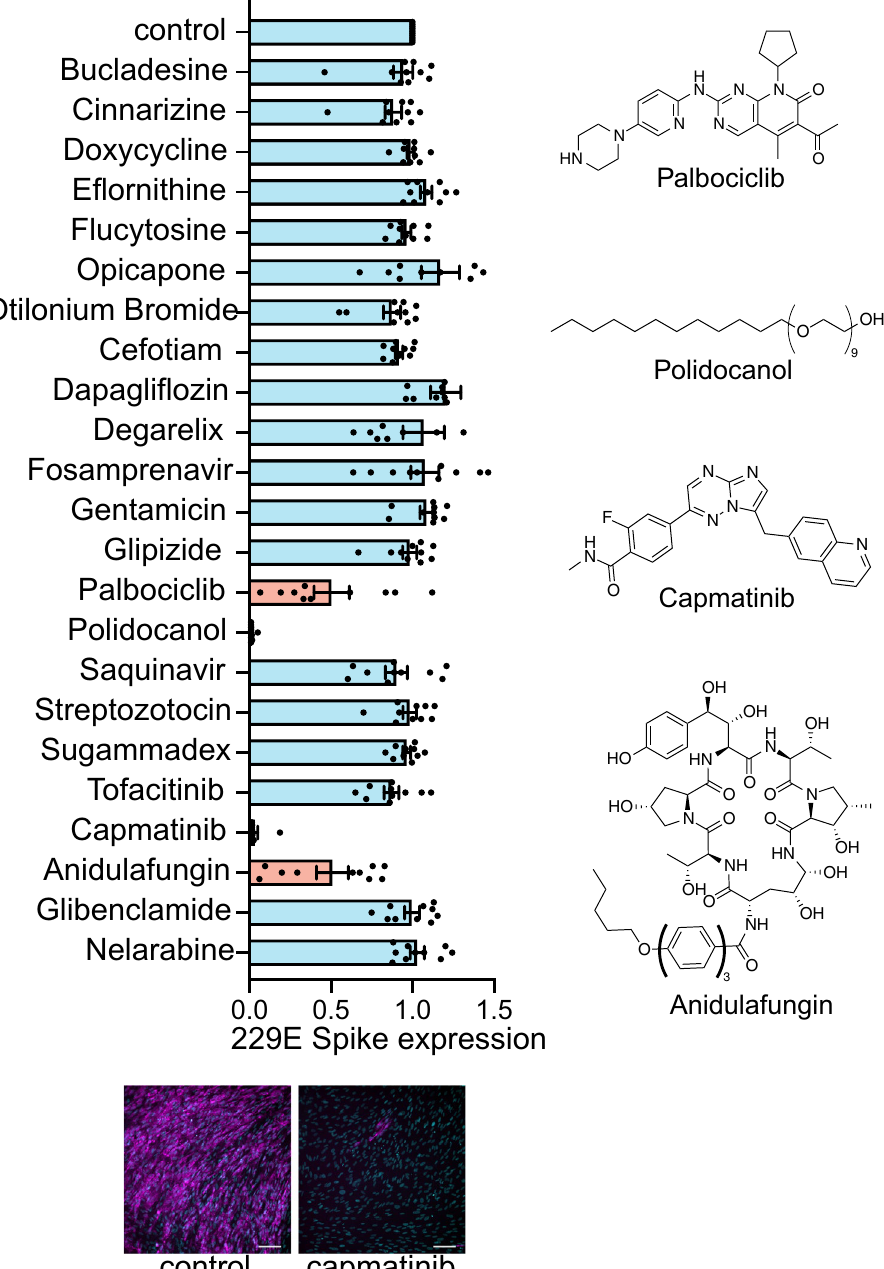
Figure 2. Screening of predicted compounds identifies capmatinib and other drugs as host-targeted compounds with antiviral activity against human coronaviruses. Graph depicting mean ± SE and individual measurements of 229E Spike protein expression as measured by IF assay upon incubation with drugs as per Table S4. Results are expressed as mean 229E Spike expression relative to the DMSO vehicle (control) condition. (bottom) Representative images showing S protein expression (magenta) or DAPI (cyan) of the DMSO vehicle (control) or capmatinib (10 µM) treated conditions. Scale, 100 µm. Also shown are structures of palbociclib, polidocanol, capmatinib and anidulafungin, compounds that showed antiviral